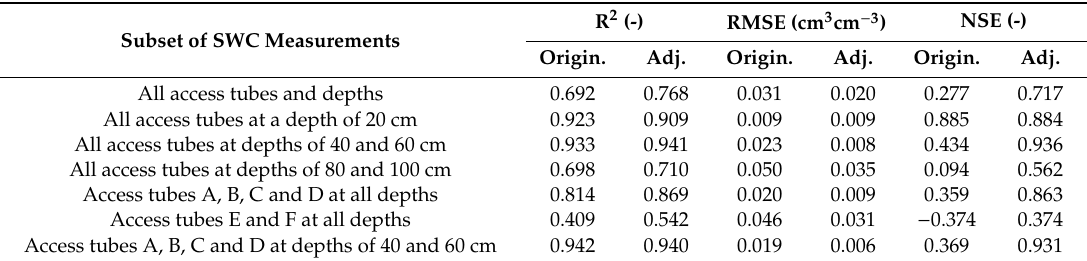
Table 8. Summary of the fit between soil water content (cm 3 cm − 3 ) measured by neutron probe in 2018 and HYDRUS-3D simulations using soil hydraulic parameters obtained from HYPROP + WP4C, with n empirically